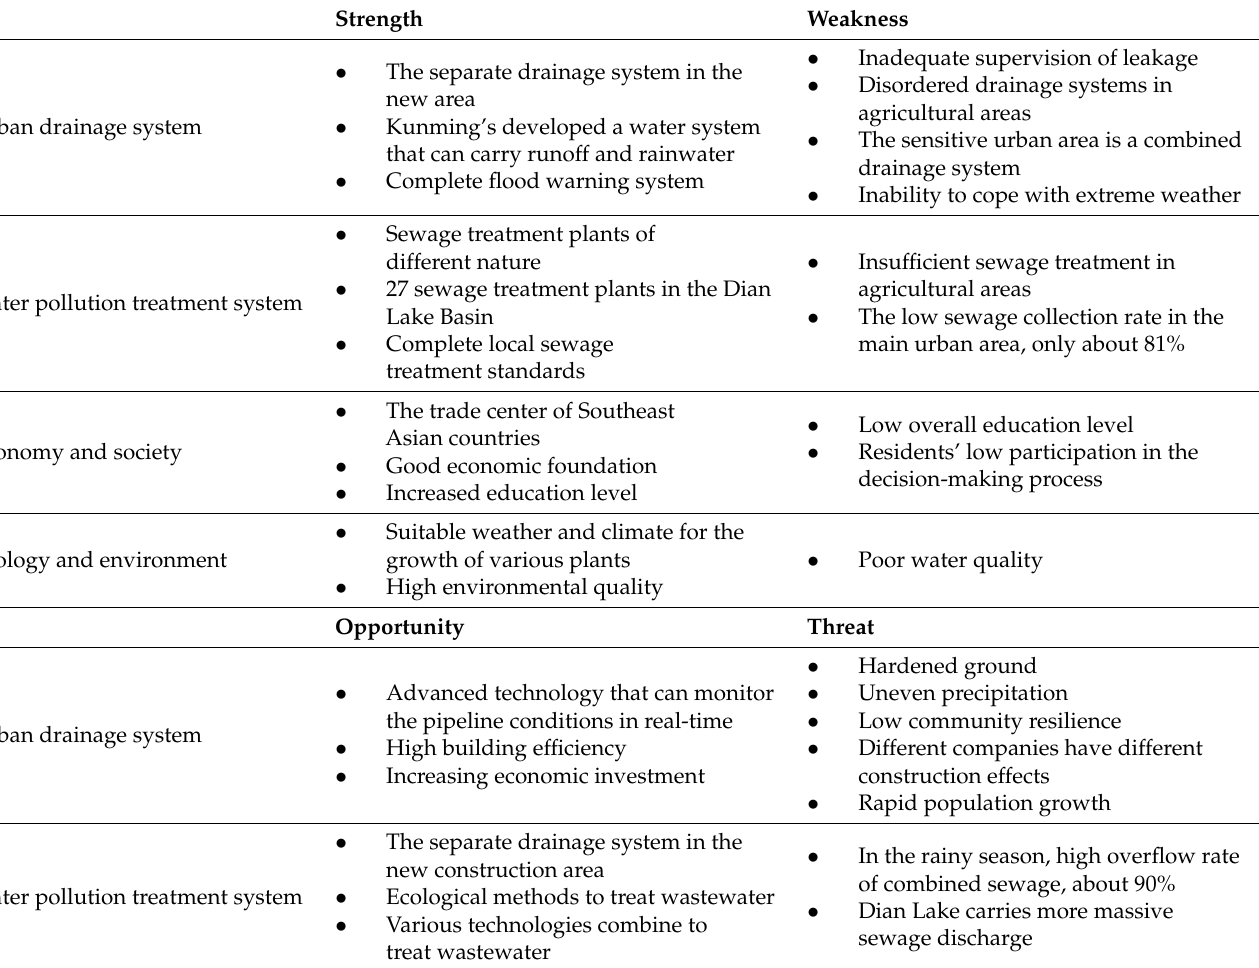
Table 4. SWOT analysis in